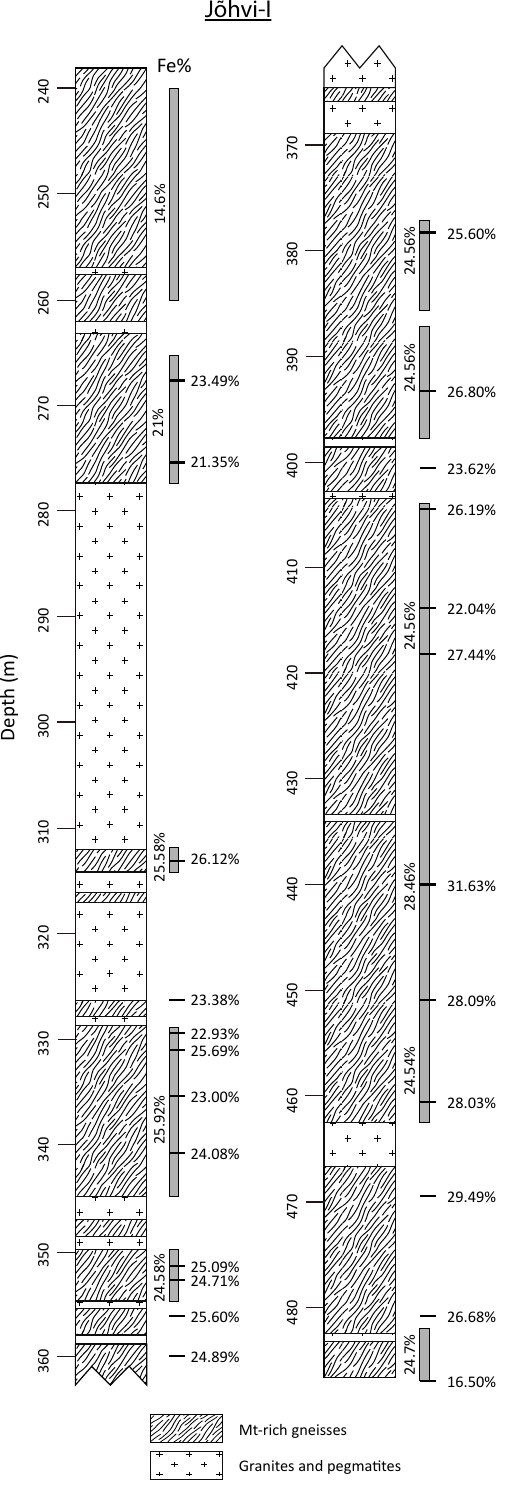
Fig. 2. Simplified cross section of drill core J­1 of the Jõhvi area. The cross section is based on the original logging in 1940 (Report No. 8, https://fond.egt.ee/fond/egf/8). Average iron contents (Fe%) are shown for ore sections (vertical values) and for sites of the present analyses (horizontal